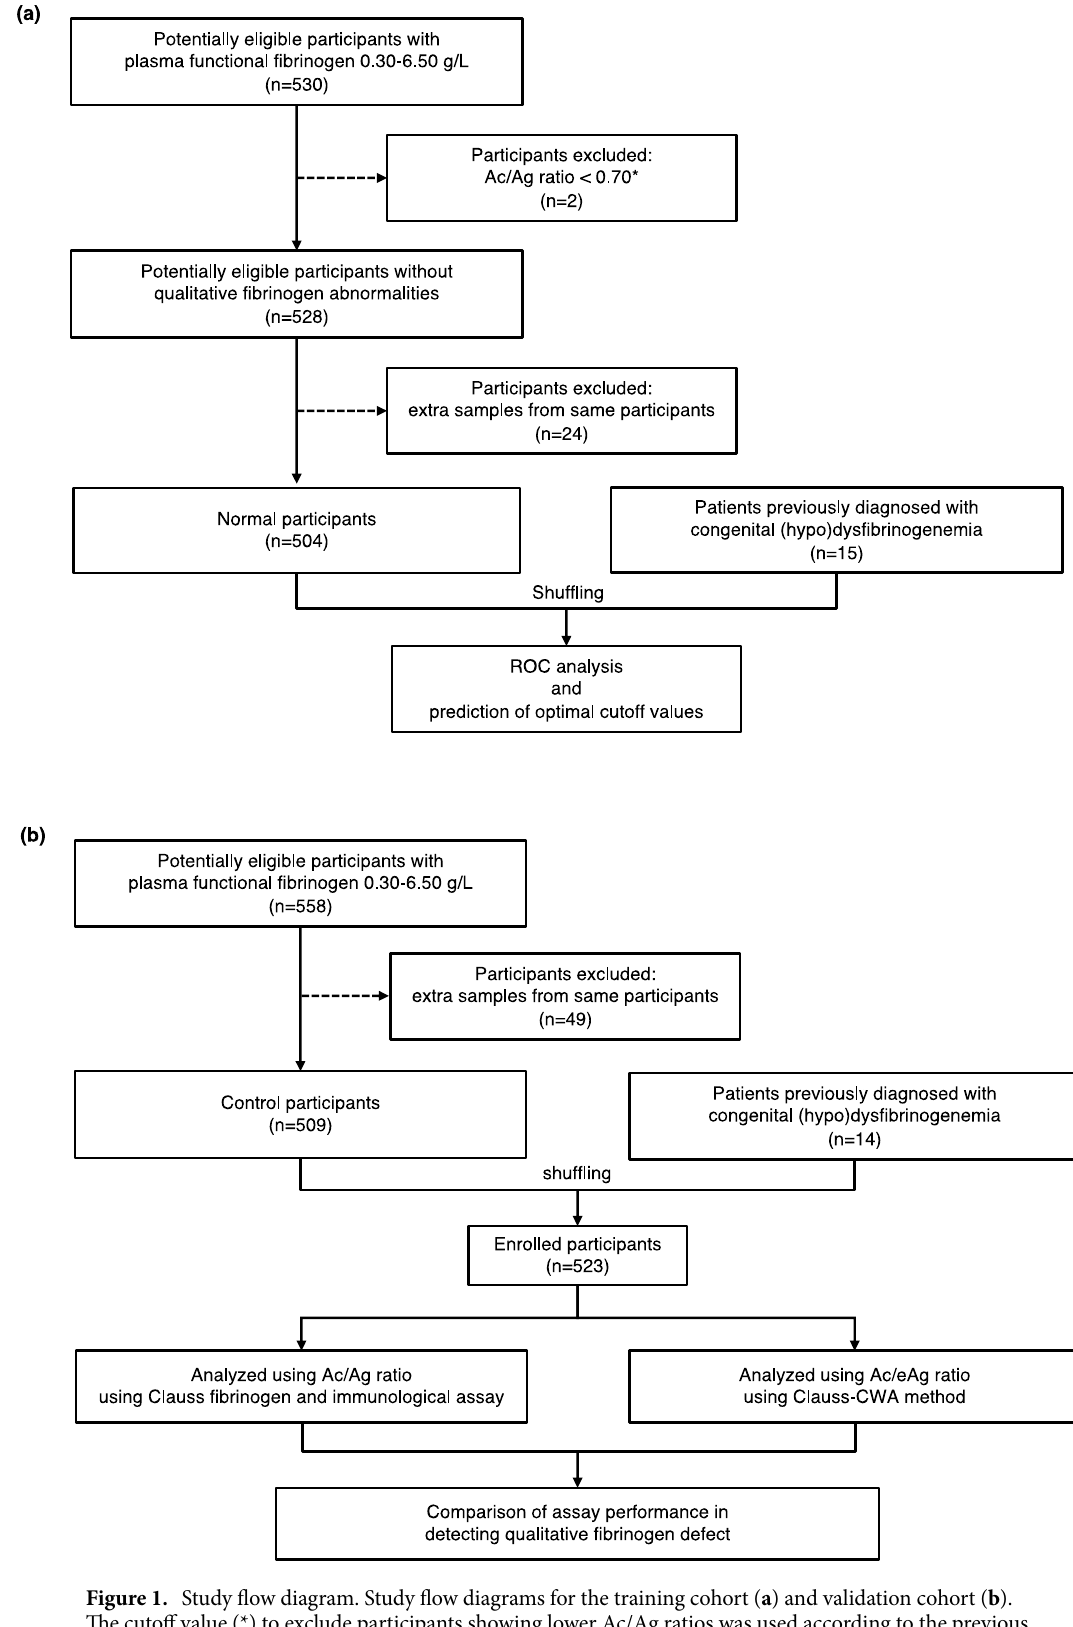
Figure 1. Study flow diagram. Study flow diagrams for the training cohort ( a ) and validation cohort ( b ). The cutoff value (*) to exclude participants showing lower Ac/Ag ratios was used according to the previous suggestion 30 . ROC, receiver operating characteristic; CWA, clot waveform